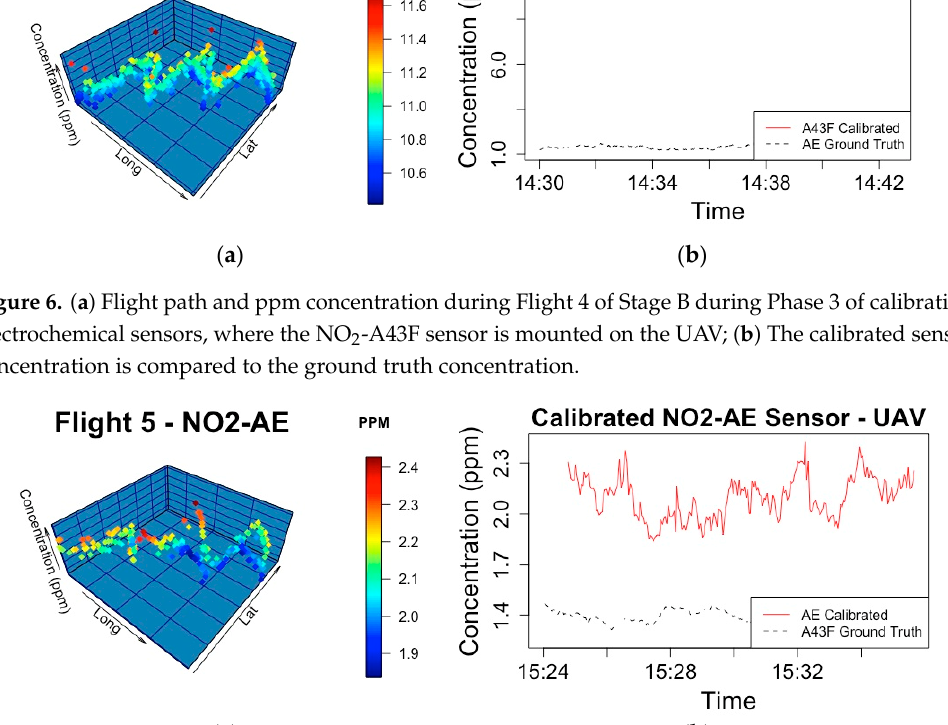
Figure 7. ( a ) Flight path and ppm concentration during Flight 5 of Stage B during Phase 3 of calibrating electrochemical sensors, where the NO 2 -AE sensor is mounted on the UAV; ( b ) The calibrated sensor concentration is compared to the ground truth concentration.